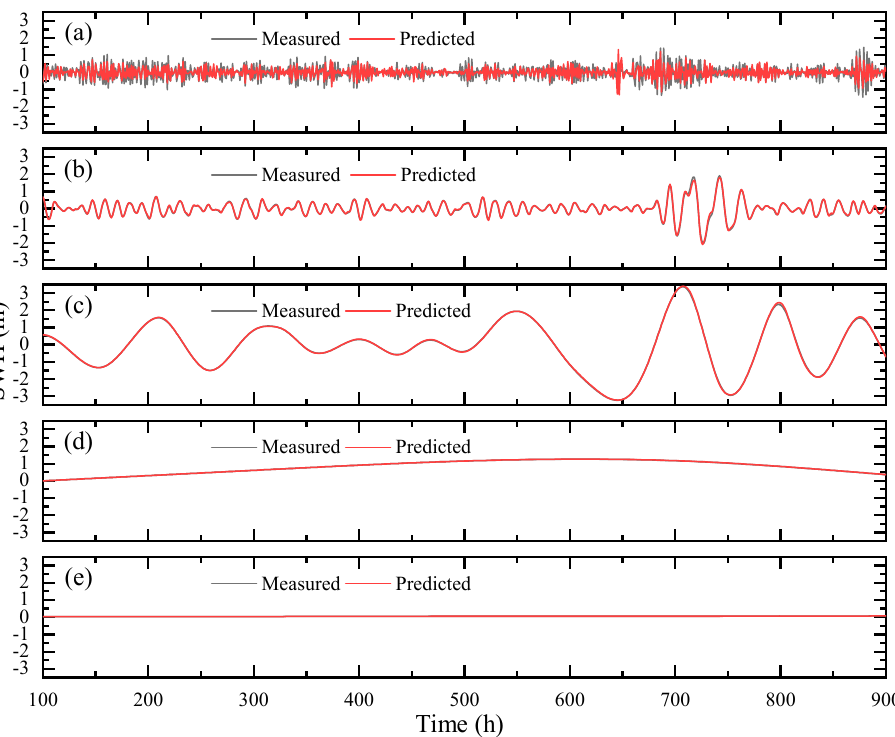
Figure 14. Comparison of measured (black) and CEEMDAN-LSTM predicted (red) values with SWH forecasts of ( a ) IMF1, ( b ) IMF5, ( c ) IMF9, ( d ) IMF13 and ( e ) IMF17 in 1-h window.